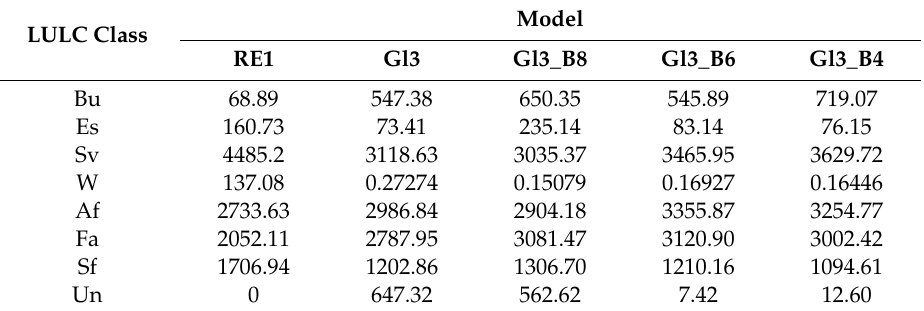
Table A1. The predicted surface area (ha) of land cover / land use for the optical multispectral image and the GLCM textures at four di ff erent grey levels of quantization.